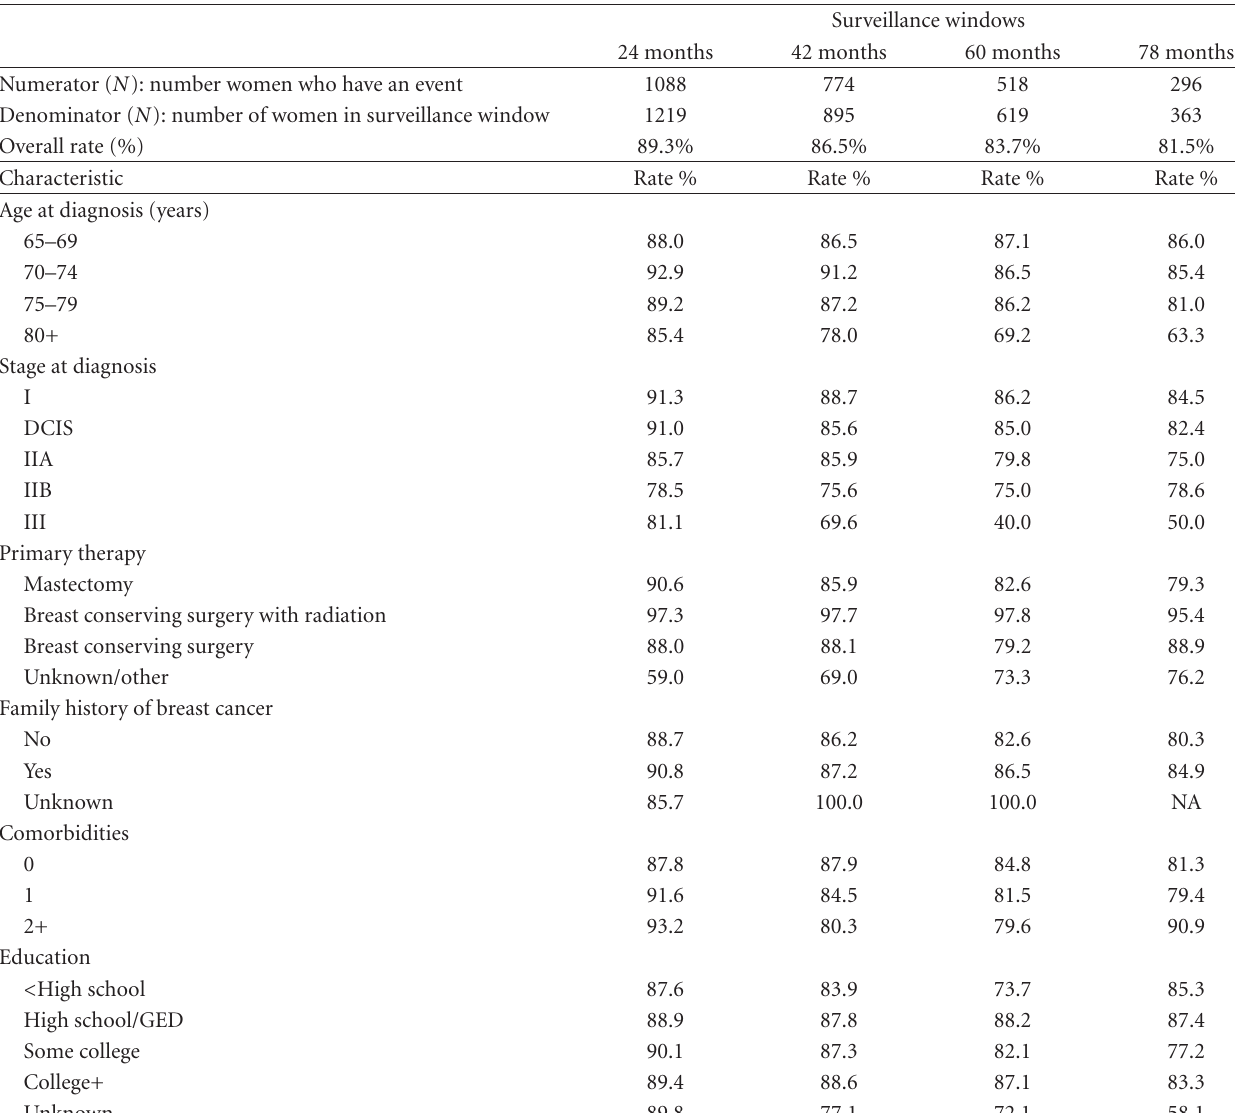
Table 2: Women’s characteristic and mammographic rates for each surveillance